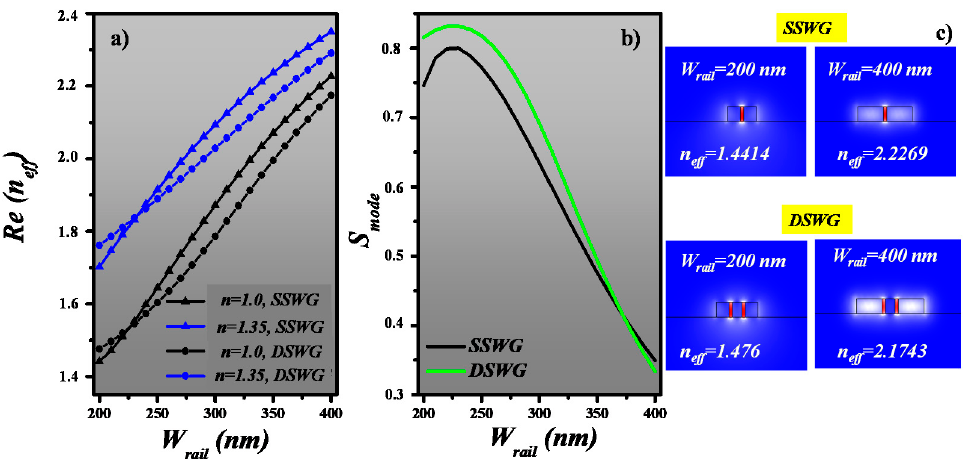
Figure 3. ( a ) Real part of the e ff ective refractive index of SSWG and DSWG, ( b ) Mode sensitivity analysis, ( c ) E-field distribution in SSWG and DSWG at W rail = 200 and 400 nm.